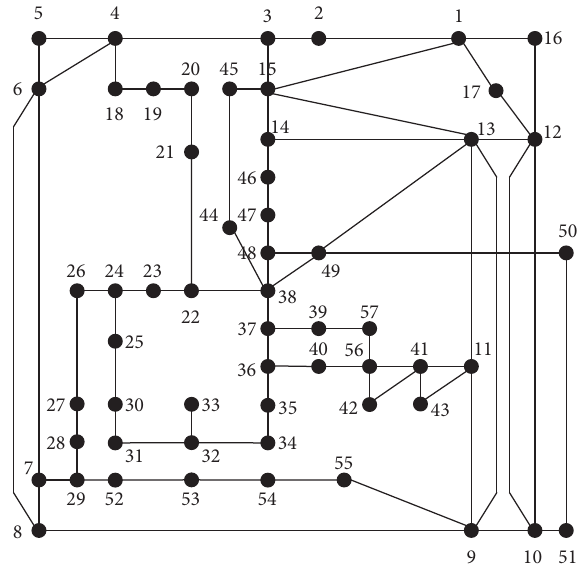
Figure 6: The IEEE57-bus test